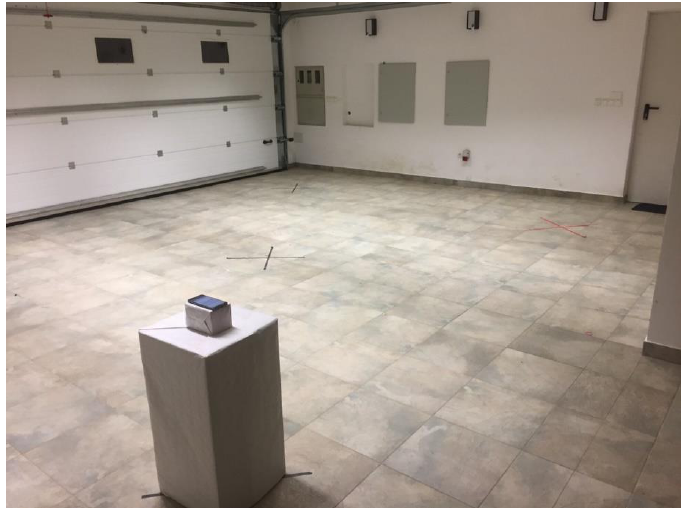
Figure 3. Testing environment with low or no obstacle severity.